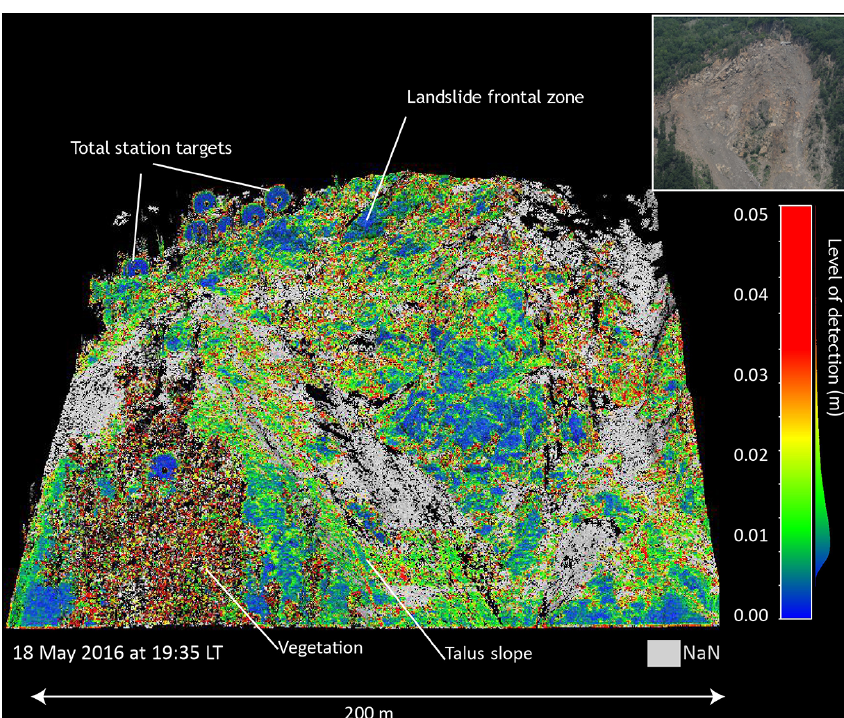
Figure 8. Variability in the spatio-temporal confidence interval in space for the most active area of the slope (Fig. 1). Level of detection mapped onto point clouds collected on 18 May